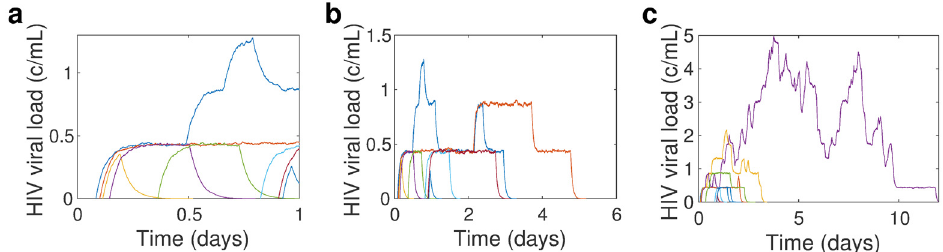
Fig 3. Stochastic simulation realization [47] of viral load dynamics resulting from a single day ’ s latent cell activations for (a-b) drug efficacy ε = 0.9, associated with R = 0.23 and mean viral load V 0 (cid:5) 4 copies/mL, and (c) ε = 0.6, associated with R = 0.92 and mean viral load V 0 (cid:5) 38 copies/mL. In (a) we show the time span of a single day, to illustrate a single day ’ s dynamics, while in (b-c) we show dynamics until the lineages created by all activations from a single day, die out. Note that in each case, the latent cell activations occur at the same time. The latent reservoir decay rate η 2 = log(2)/44 months and aL 0 is chosen so that the on-therapy quasi- steady state viral load is V 0 = 3.1 copies/mL assuming baseline drug efficacy ε = 0.99, infected cell death rate δ = 1 day − 1 , and latency fraction f = 10 − 4